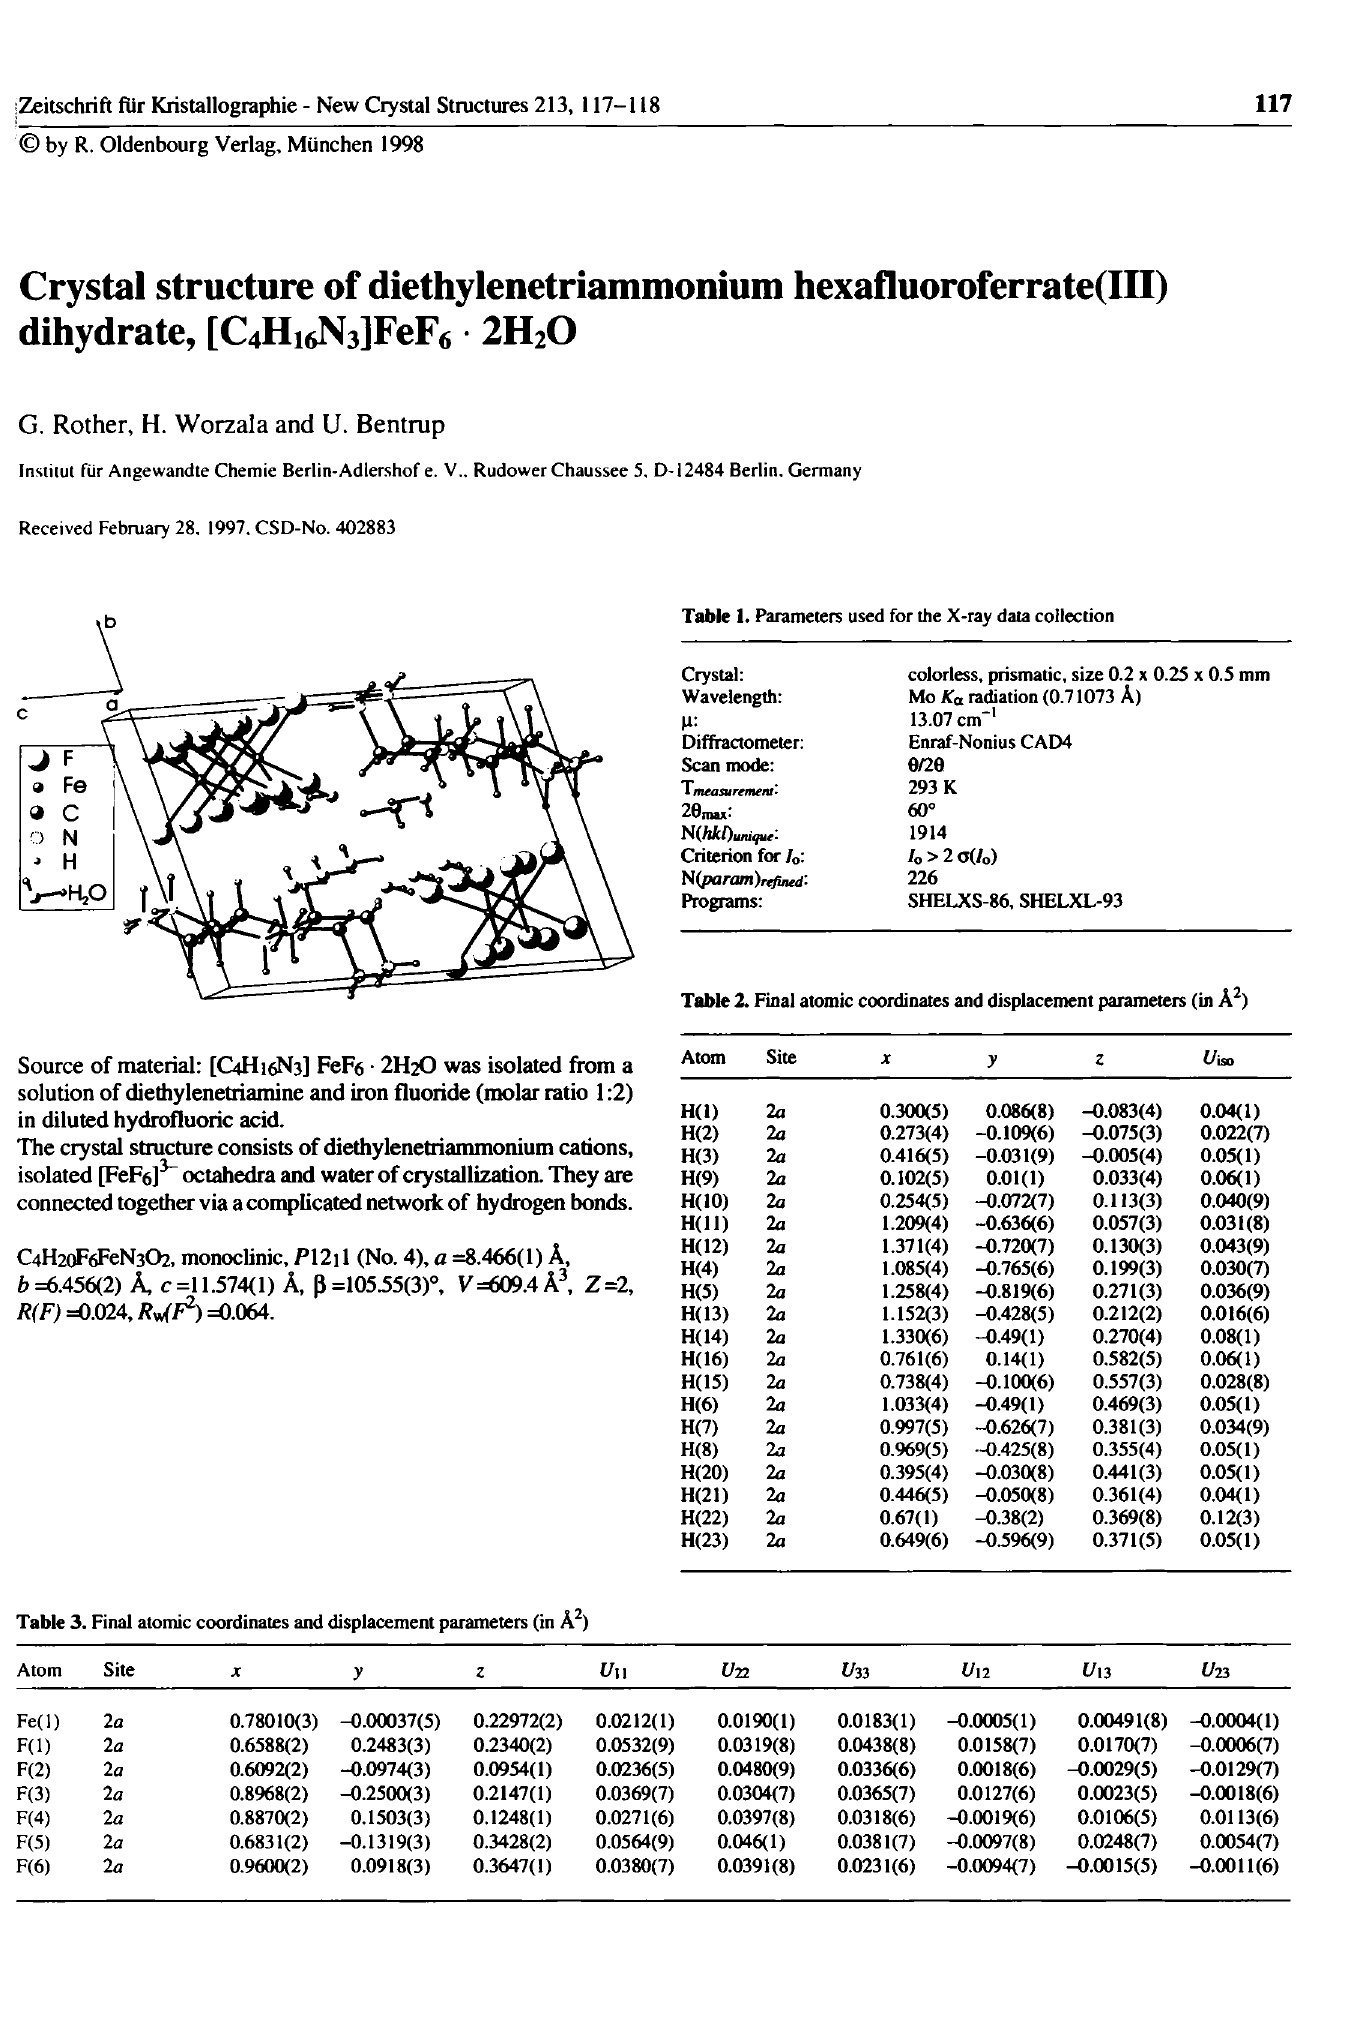
Table 3. Final atomic coordinates and displacement parameters (in